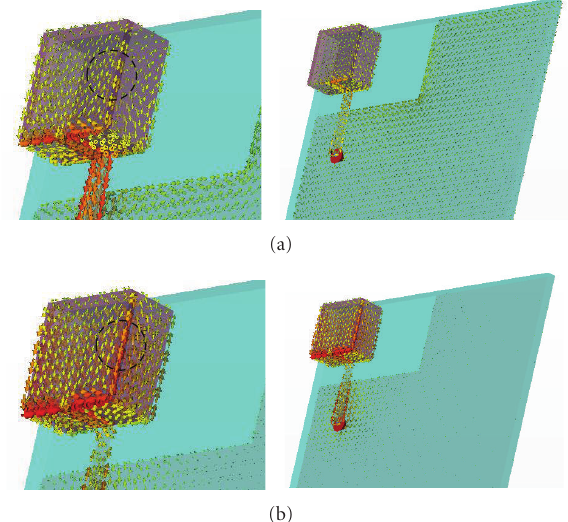
Figure 6: Current distribution of gaps between radiator and side parasitic elements for band-stop. (a) 3.15GHz, (b) 5.8 GHz.